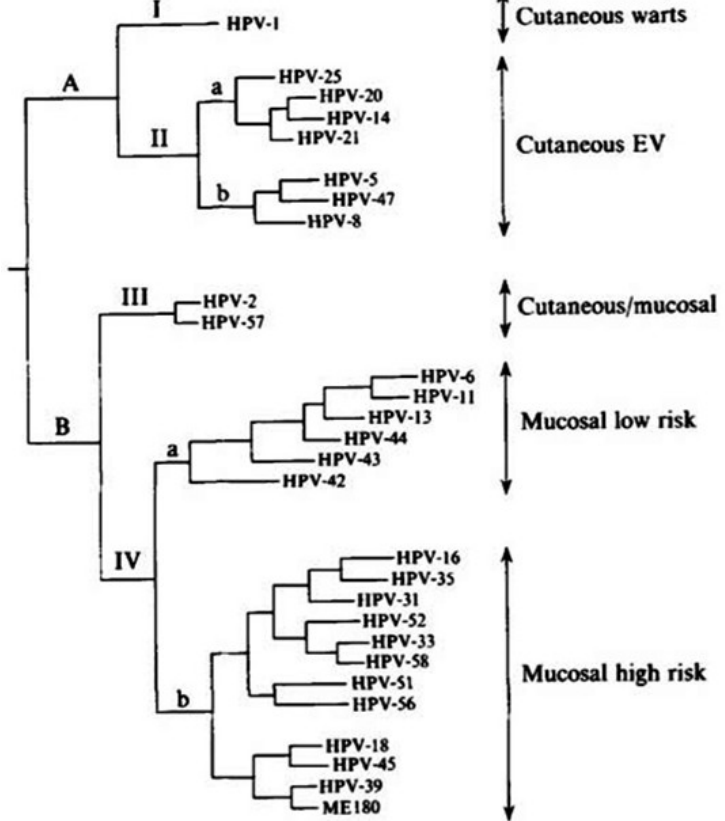
Figure 1. Phylogenetic tree constructed from the alignement of 384 nucleotides in the E6 genes of 28 HPVs using maximum parsimony analysis (PAUP 3.0). The labels on the right indicate the corresponding clinical category associated with each HPV type. (From Van Ranst et al .